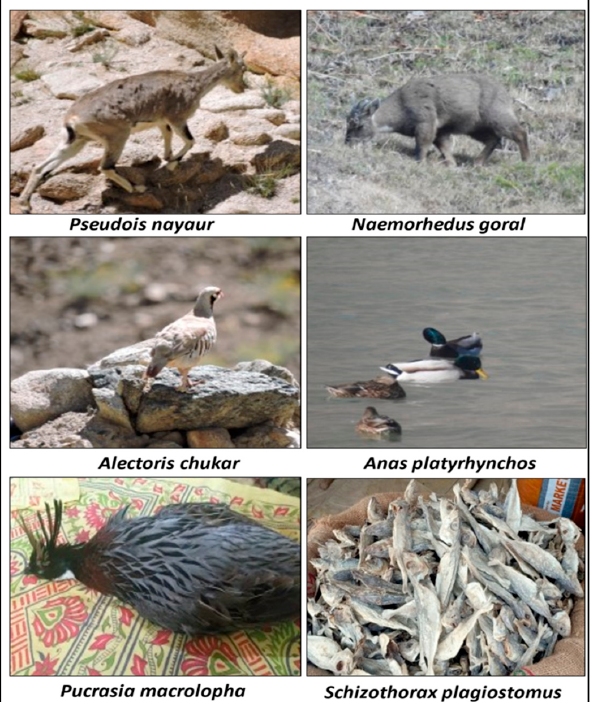
Figure 4. Representative ethno-wild food (animals) used by indigenous people. The photographs were taken by Shiekh Marifatul Haq and Musheer ul Hassan.